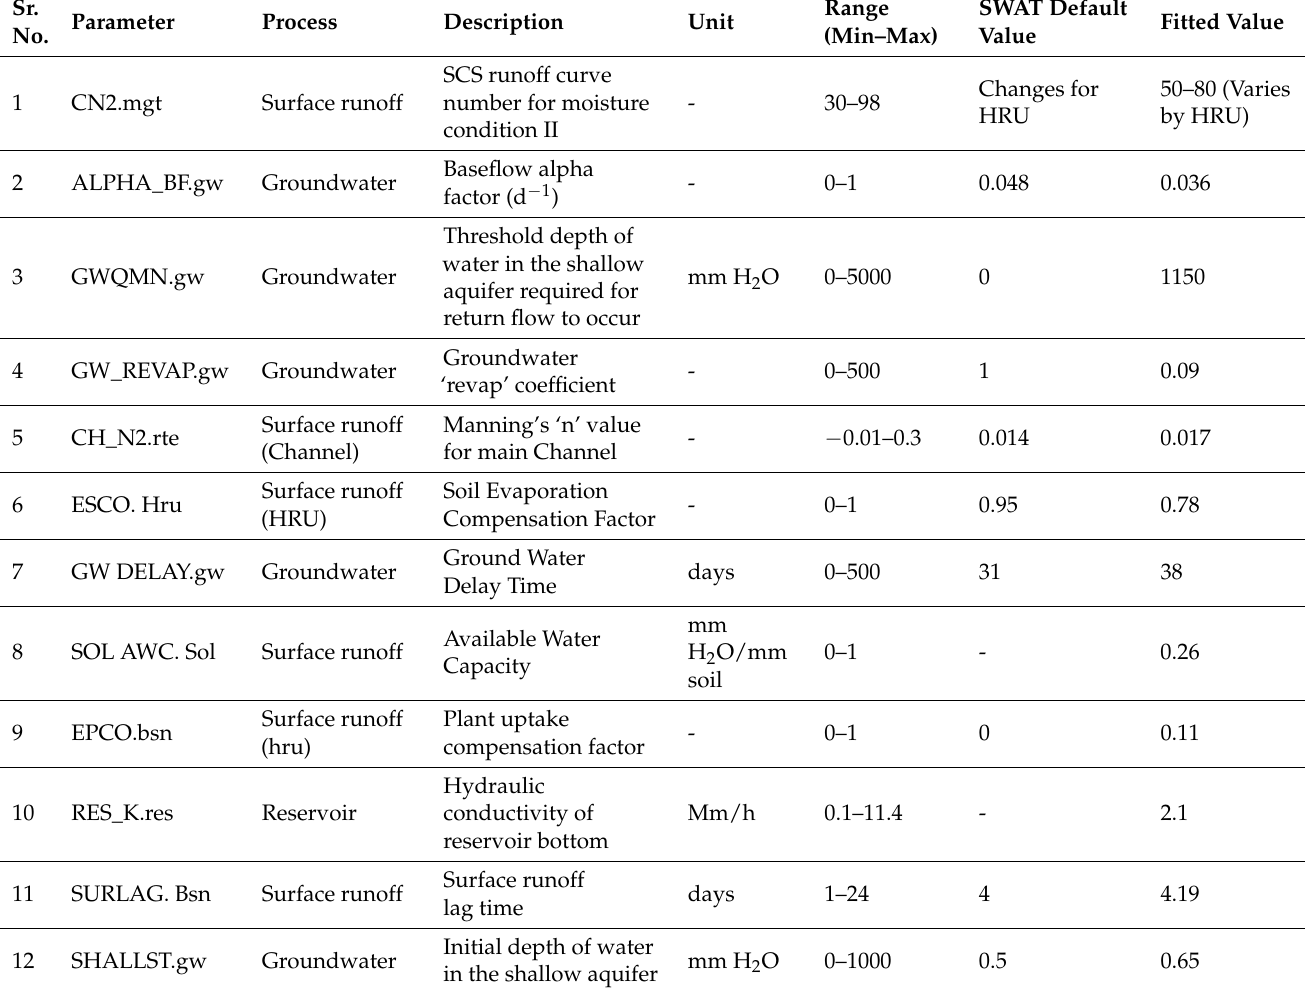
Table 1. SWAT model parameters, process, their description, parameter ranges, default value, and fitted value in the stepwise calibration